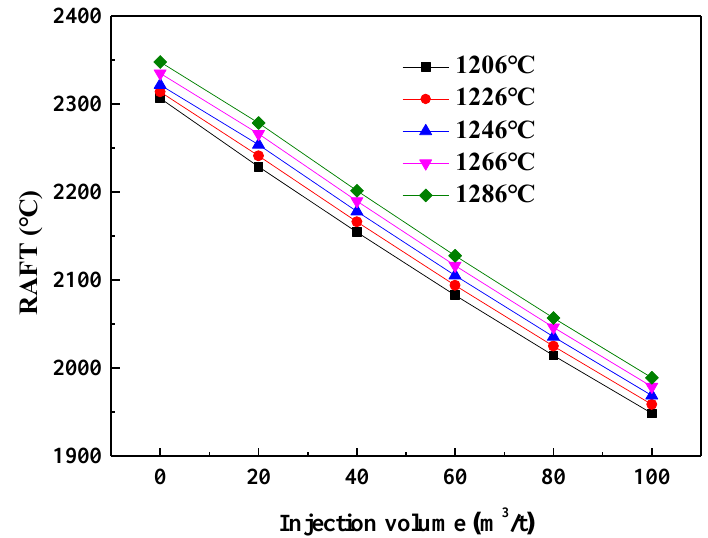
Figure 5. Effect of NG injection on heat loss in the high temperature zone of blast furnace under Figure 9. Effect of NG injection on RAFT under different blast temperatures. Figure 9. Effect of NG injection on RAFT under different blast temperatures. different coal ratios.